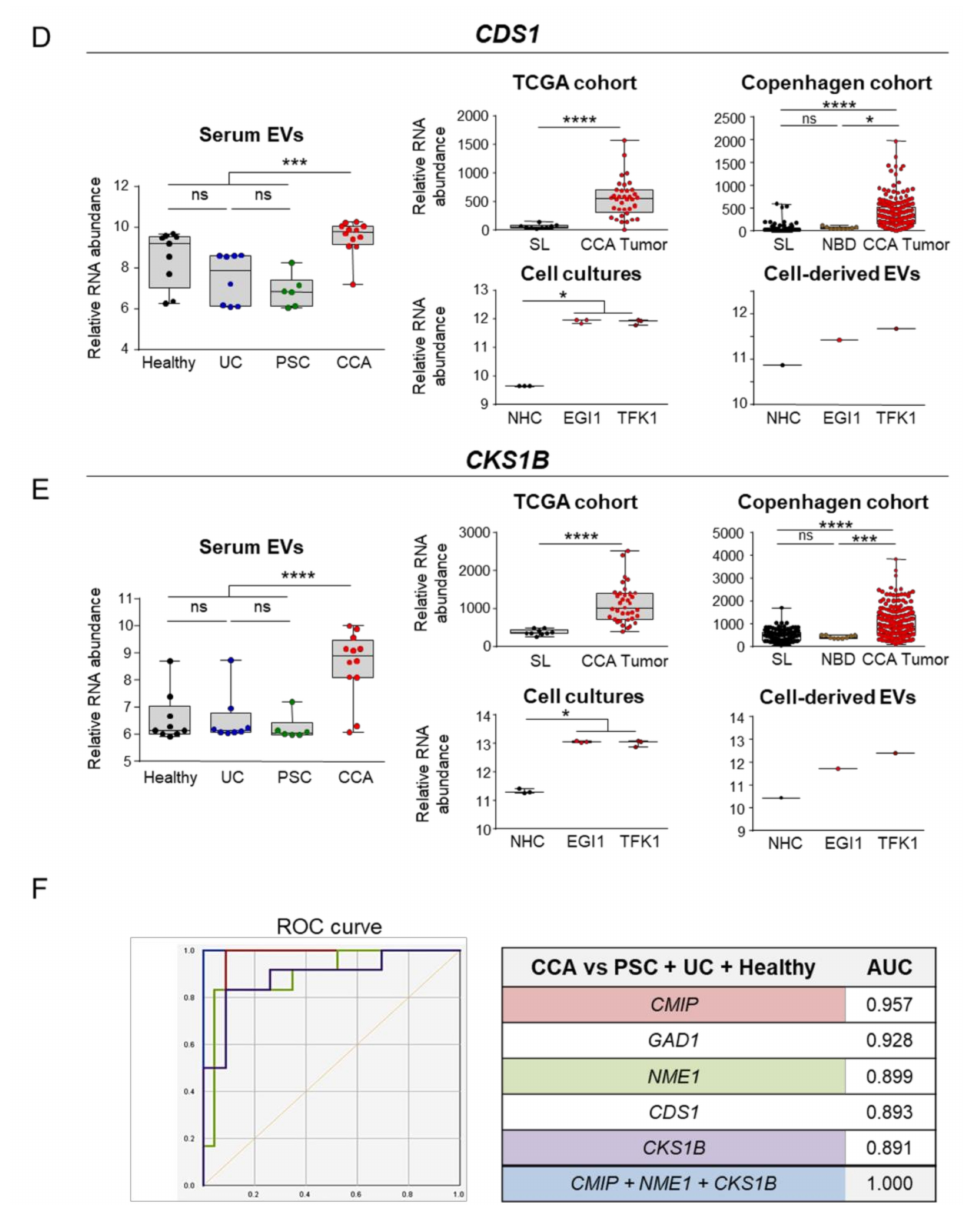
Figure 5. Selected liquid biopsy biomarkers for CCA. From the 105 mRNAs commonly altered in serum EVs, CCA human tumors, CCA cells and in cell-derived EVs compared to their corresponding controls, 5 biomarkers were selected based on their diagnostic capacity. Box plot diagrams with the mRNAs abundance in serum EVs (left), CCA tumors from the TCGA, and “Copenhagen” cohorts, CCA cells and cell-derived EVs (right), compared to their respective controls, for ( A ) c-Maf inducing protein ( CMIP ), ( B ) glutamate decarboxylase 1 (GAD1) , and ( C ) NME / NM23 nucleoside diphosphate kinase 1 (NME1) ; ( D ) CDP-diacylglycerol synthase 1 (CDS1) , and ( E ) CDC28 protein kinase regulatory subunit 1B (CKS1B) . ( F ) Diagnostic prediction (ROC curves and AUC values) of the selected serum liquid biopsy biomarkers and for the combination of CMIP, NME1 and CKS1B for the diagnosis of CCA in comparison with (PSC + UC + Healthy individuals). Abbreviations: AUC, area under the receiver operating characteristic (ROC) curve; EVs, extracellular vesicles; NHC, normal human cholangiocyte; NBD, normal bile ducts; SL, surrounding liver; TCGA, the cancer genome